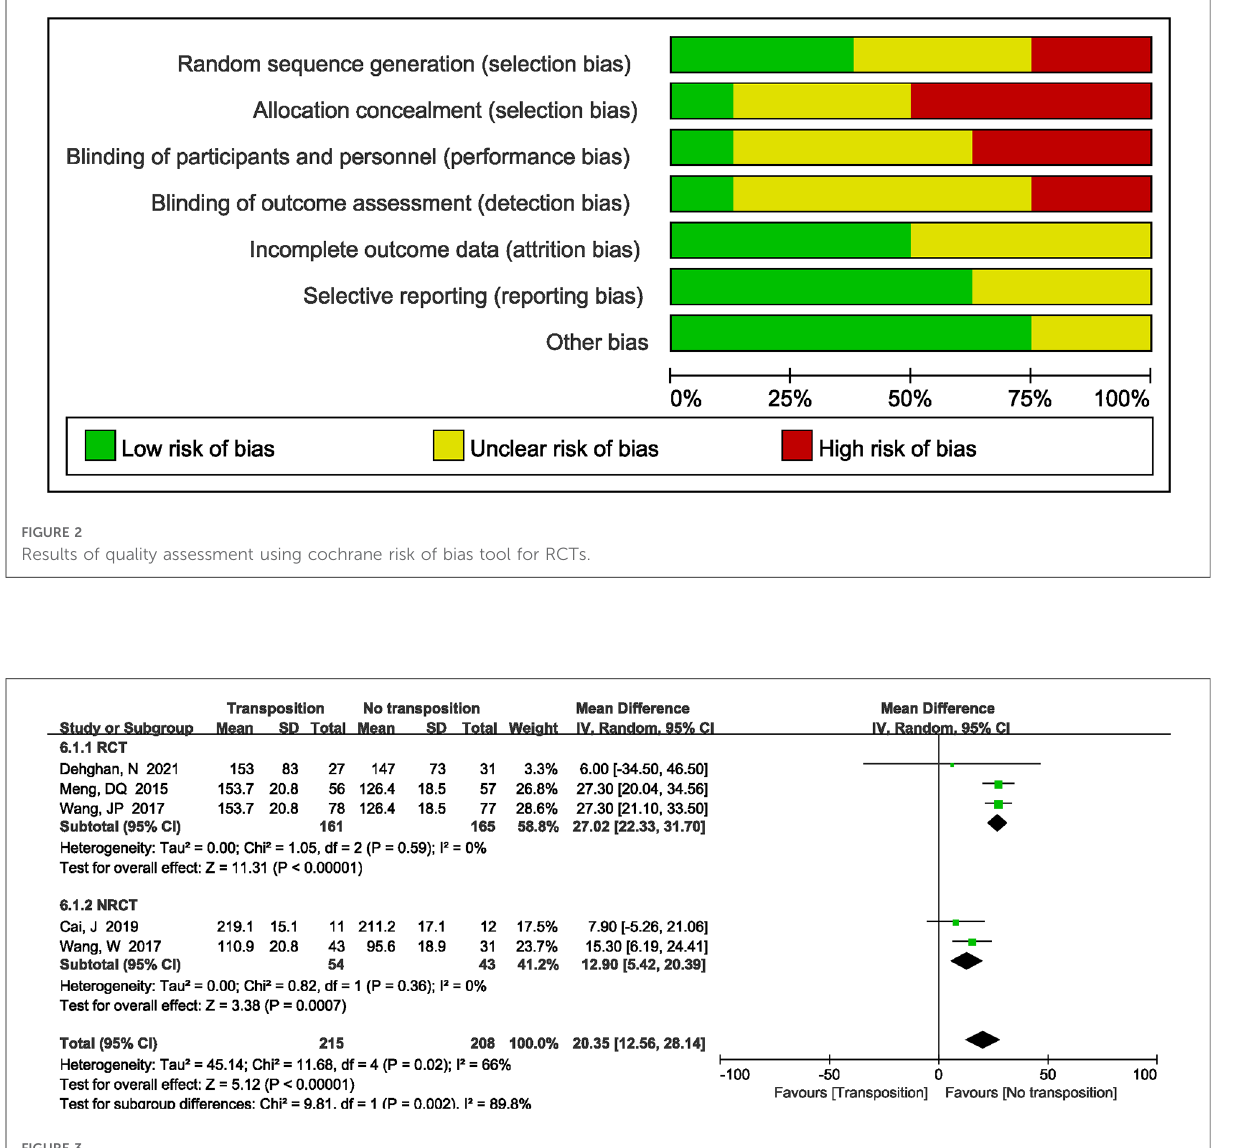
FIGURE 3 A forest plot showing the operation